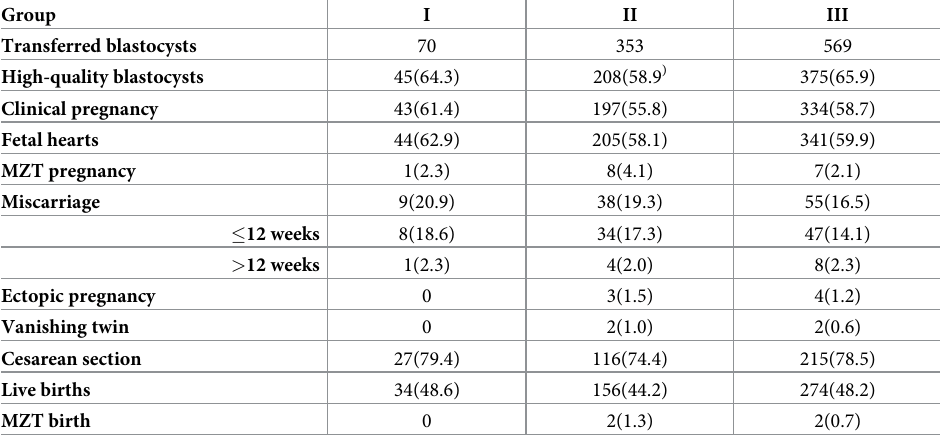
Table 4. Clinical outcomes of PGD/PGS patients transferred a single blastocyst with different hatching types.